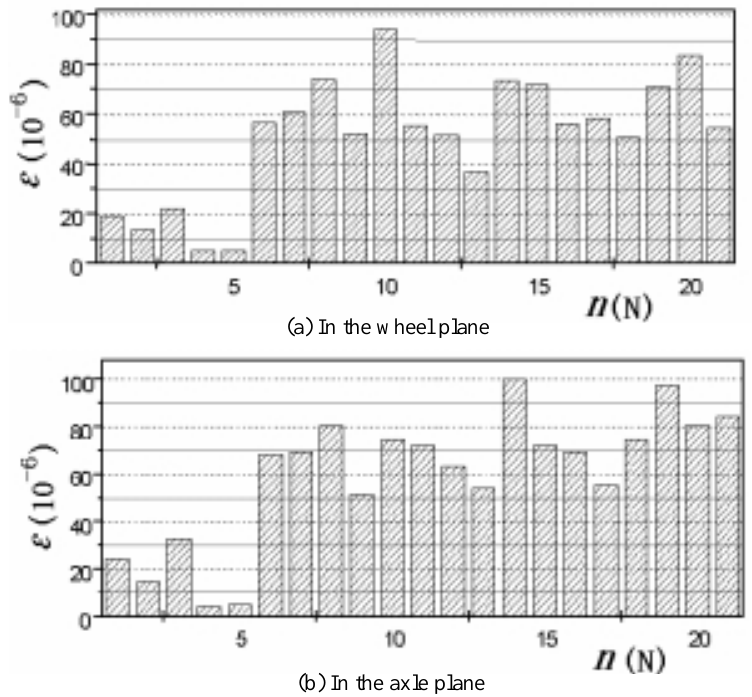
Fig. 11. (a) In the wheel plane (b) In the axle plane The statistics of the strain measures for the piston rod in real road test.